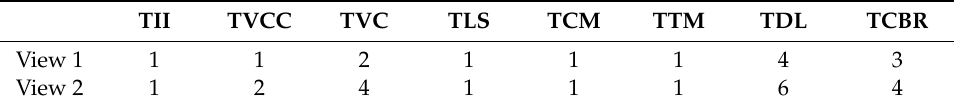
Table 2. Process units of tasks performed by